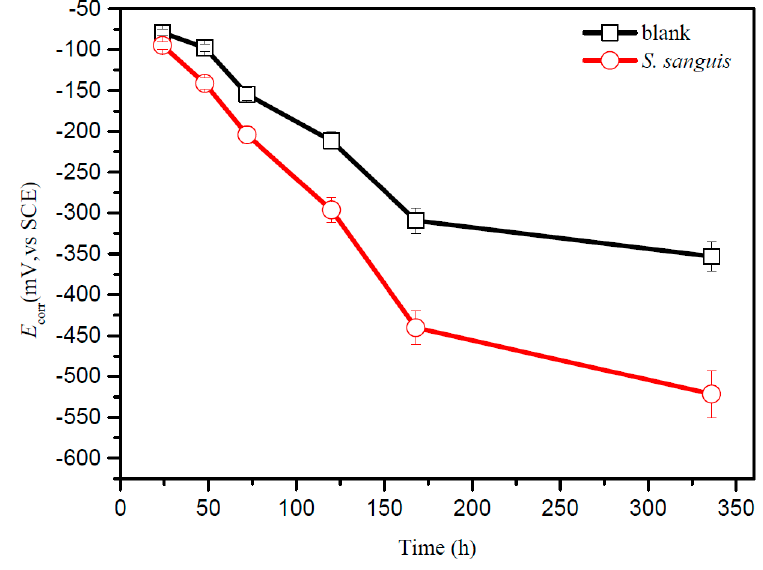
Figure 3. Variation of the open circuit potential (OCP) of titanium in enriched artificial saliva with S. sanguis at 37